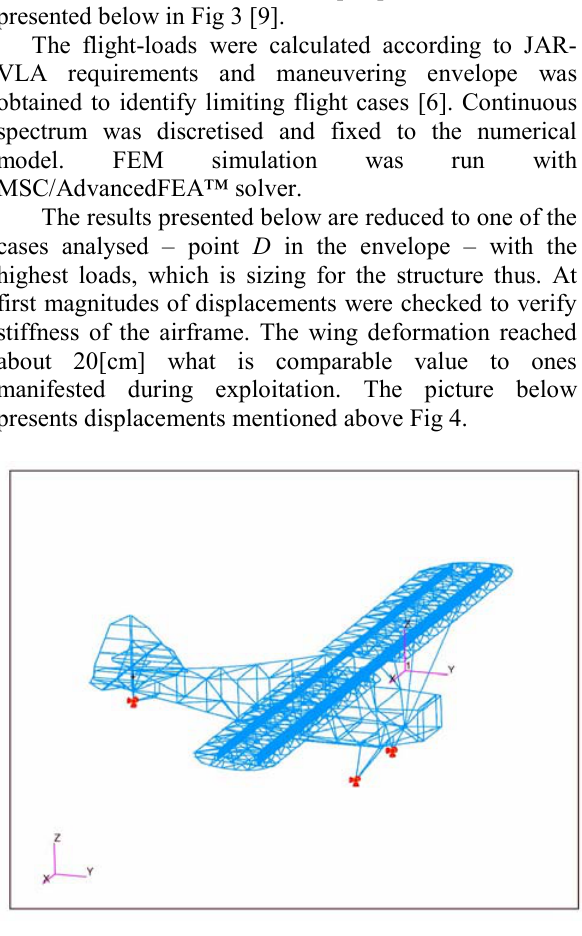
Fig 3. The numerical model of light airplane structure